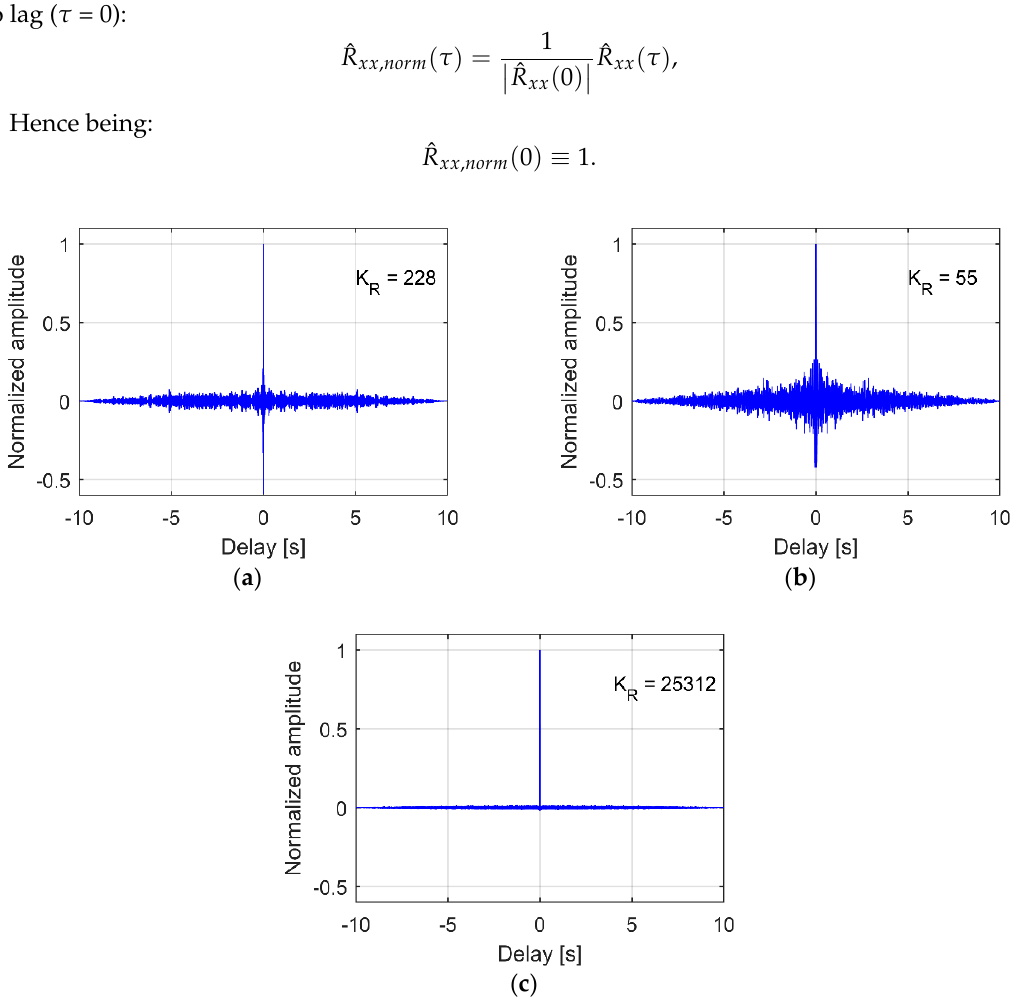
Figure 3. Normalized autocorrelation function of: ( a ) Condition L1 acceleration signal (Test-2, radial accelerometer sensor (Aax), 2nd acquisition of the dataset); ( b ) Condition NL1 acceleration signal (Test-2, sensor Aax, 2nd acquisition of the dataset); ( c ) Gaussian white noise. The kurtosis value ( K R ) of the normalized autocorrelation function is reported in the upper right corner.